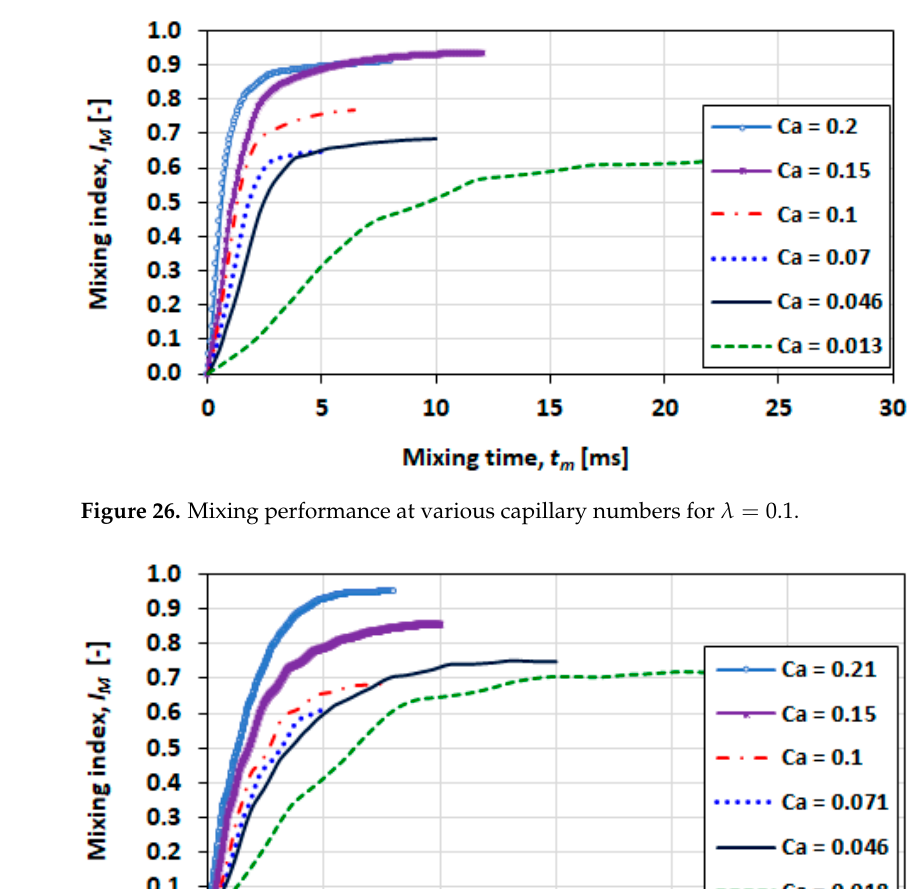
Figure 27. Mixing performance at various capillary numbers for 𝜆 = 0.5 .